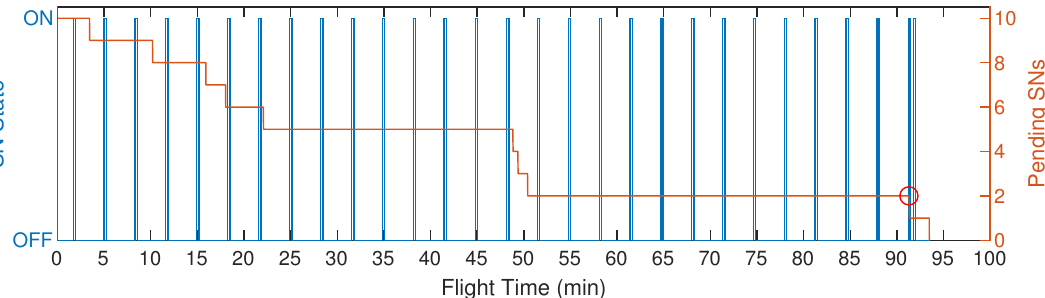
Figure 22. Graphical representation of an SN active and hibernation states, considering S 5 with 10